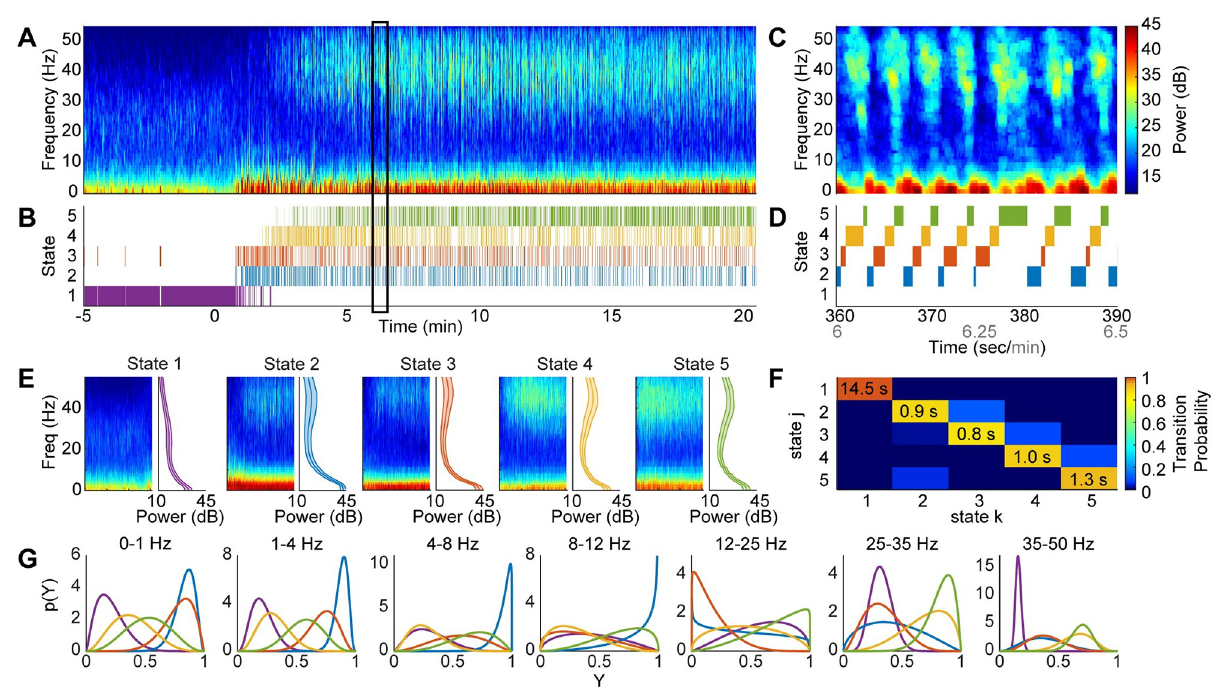
Fig 3. A 5-state beta-HMM estimates ketamine-induced neurophysiological dynamics from a single NHP LFP sequence. (A) Multitaper spectrogram of LFP where time 0 marks the time-point of administration of 20 mg/kg ketamine intramuscular bolus. (B) Estimated latent state trajectory. (C) Enlarged view of panel A for the epoch identified by the rectangular box. (D) Enlarged view of panel B for the epoch identified by the rectangular box. (E) Spectral clusters identified by the 5-state beta-HMM. Each spectral cluster has a characteristic signature as indicated by the mean spectrum and corresponding standard deviation. (F) The estimated transition matrix. The expected value of the duration spent in each state is indicated on the diagonal. (G) Frequency-band specific beta distributions (over scaled power (Y) in respective bands) estimated for each of the 5 states. Each color corresponds to a state, as denoted in panel